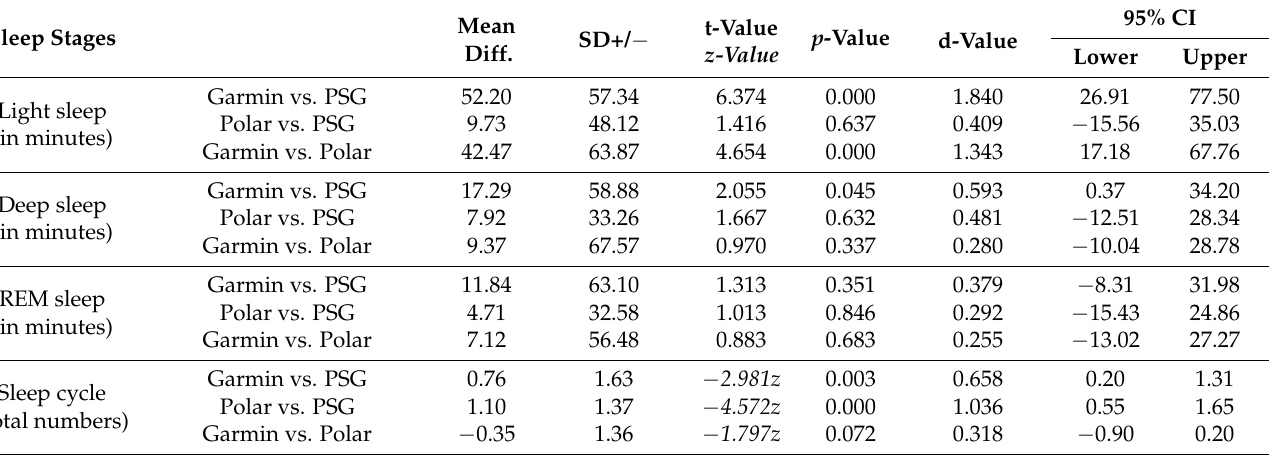
Table 6. Sleep stages of Garmin Forerunner 945, Polar Ignite and ActiGraph GT9X and their compari- son with the gold standard PSG ( n = 49).